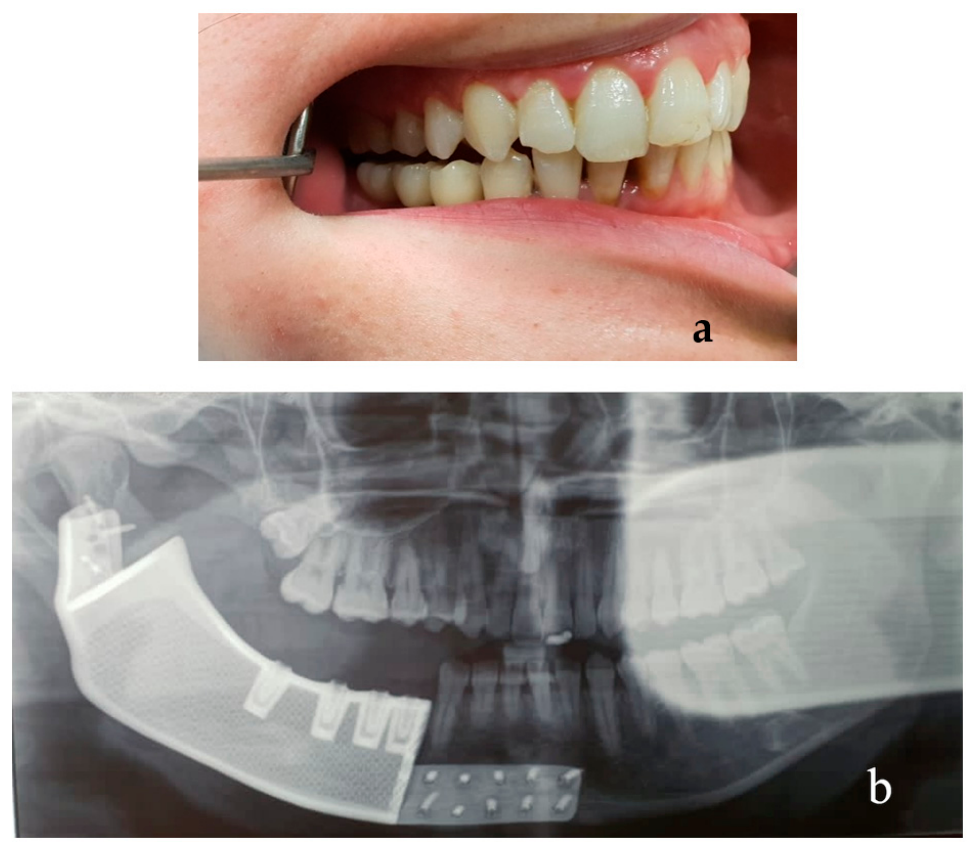
Figure 12. ( a ) Post-surgery view of intraoral rehabilitation. ( b ) Post-surgery panoramic X-ray of the positioned mandibular prosthesis.